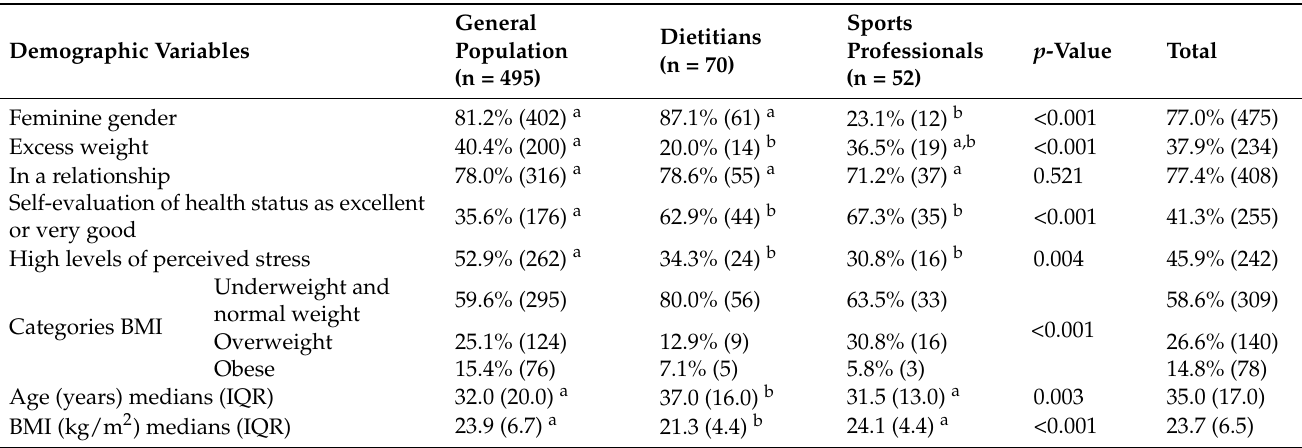
Table 1. Demographic variables per study